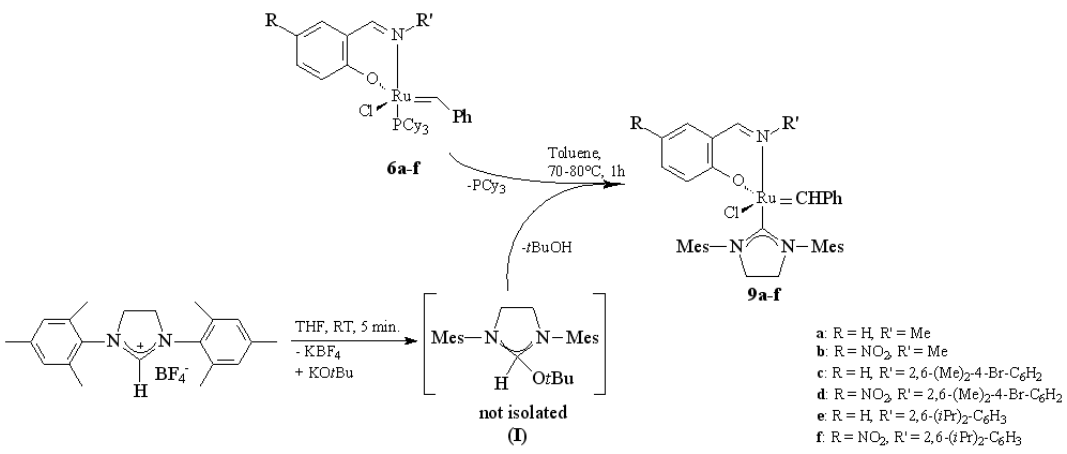
Scheme 5 Synthesis of NHC ruthenium benzylidene containing complexes, 9a-f